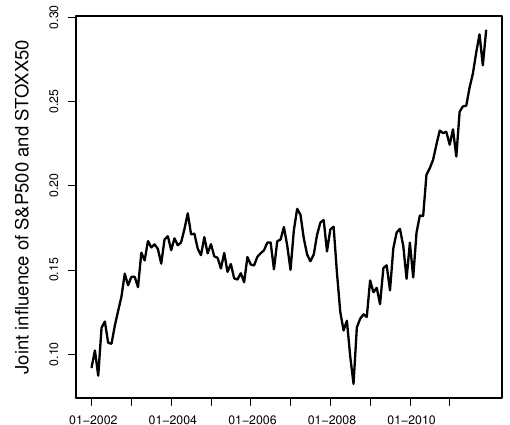
Figure 9. Sensitivity of the logarithmized ARR on S&P500 and STOXX50. Similar to the model with unshifted explanatory variables, the above two models based on the stochastically estimated GGDP Europe and GGDP USA outperform the corresponding ones with linearly interpolated GGDP Europe and GGDP USA in terms of R 2 and adjusted R 2 . The estimation accuracy of Model (6) is presented in Figure 10, adj where the fitted values are plotted together with the observed values. Model (6) seems to fit the ARR very well since the estimated and observed ARR are very close to each other.